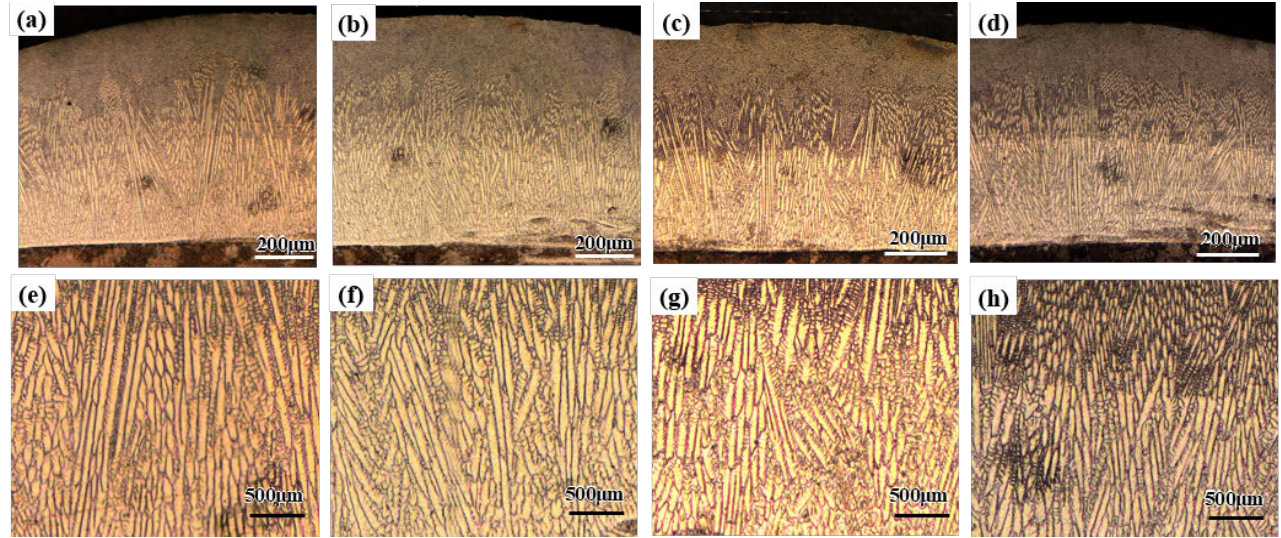
Figure 5. Cross-sectional morphology of laser cladding with or without vibration: ( a ) without vibration; ( b ) with 1D vibration; ( c ) with 2D vibration; ( d ) with 3D vibration; ( e ) without vibration in high magnifications; ( f ) with 1D vibration in high magnifications; ( g ) with 2D vibration in high magnifications; ( h ) with 3D vibration in high magnifications.